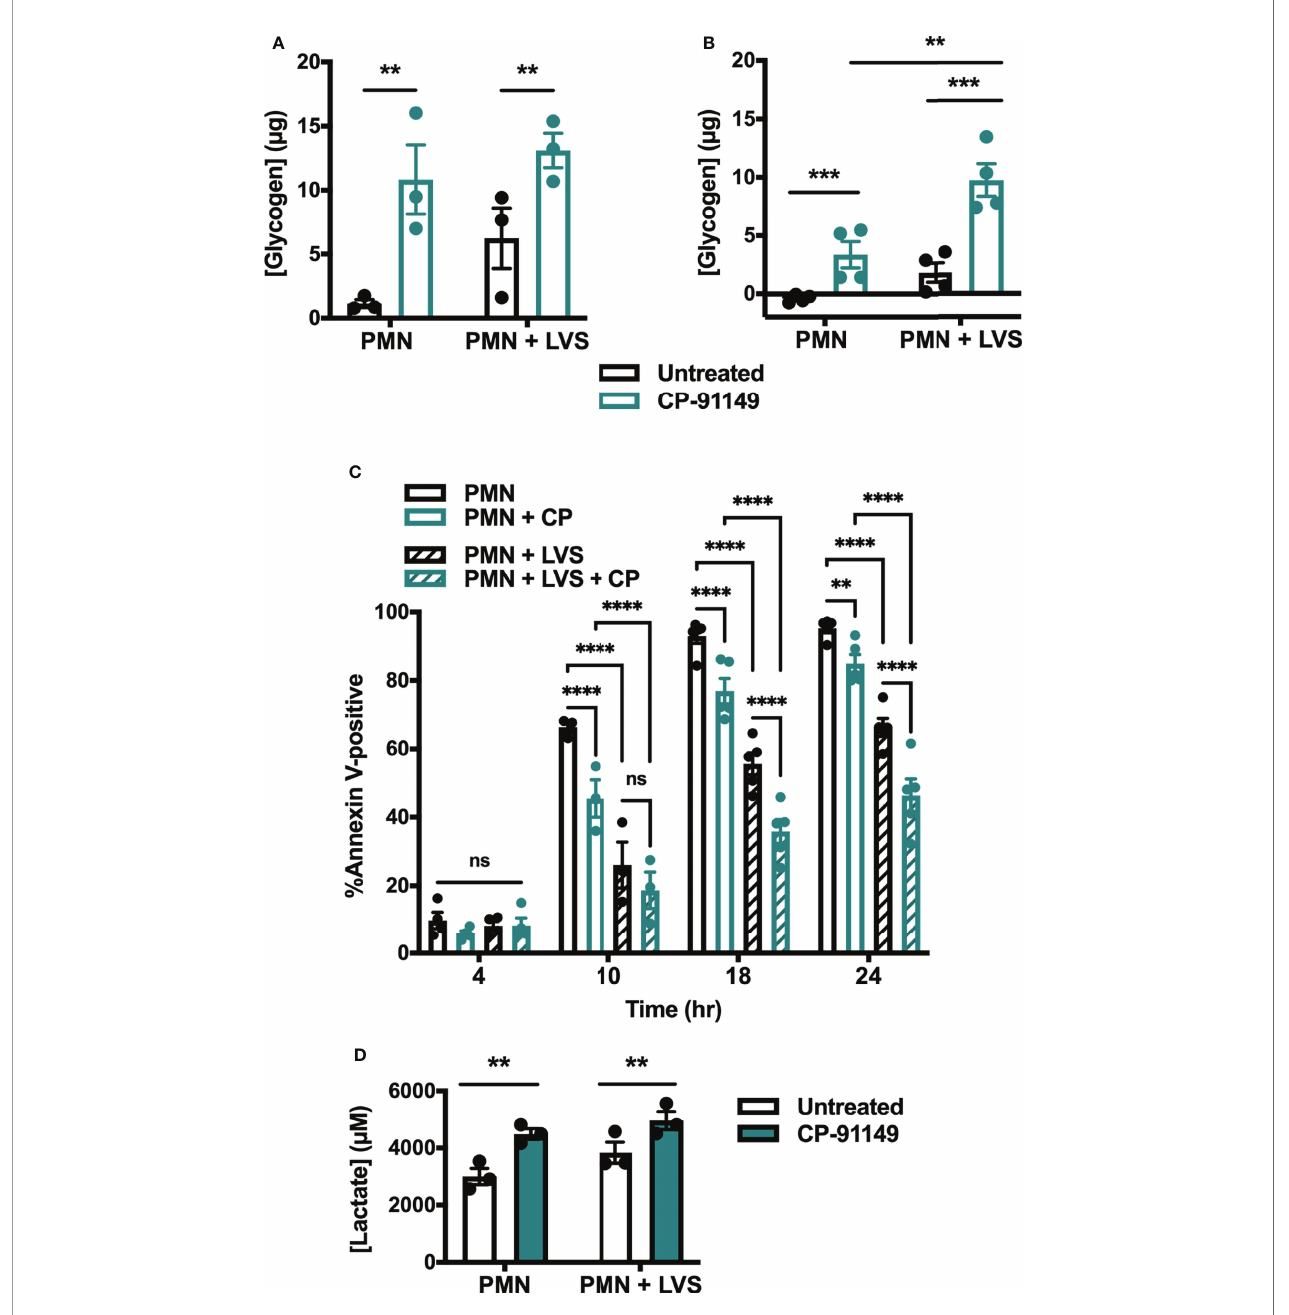
FIGURE 8 | Glycogen abundance correlates with delayed apoptosis. (A, B) Glycogen abundance in uninfected and LVS-infected PMNs in the presence or absence of CP-91149 at 6 hr (A) and 24 hr (B) , n=3-4. ** p < 0.01, *** p < 0.001 as indicated. (C) Apoptosis of uninfected and LVS-infected PMNs in the presence or absence of CP-91149 quanti fi ed using Annexin V-FITC staining and fl ow cytometry at the indicated timepoints, n=3-5. ** p < 0.01, **** p < 0.0001, ns, not signi fi cant, as indicated. (D) Amount of lactate released by control and LVS-infected PMNs in the presence or absence of CP-91149 at 12 hr, n=3. **p < 0.01 as